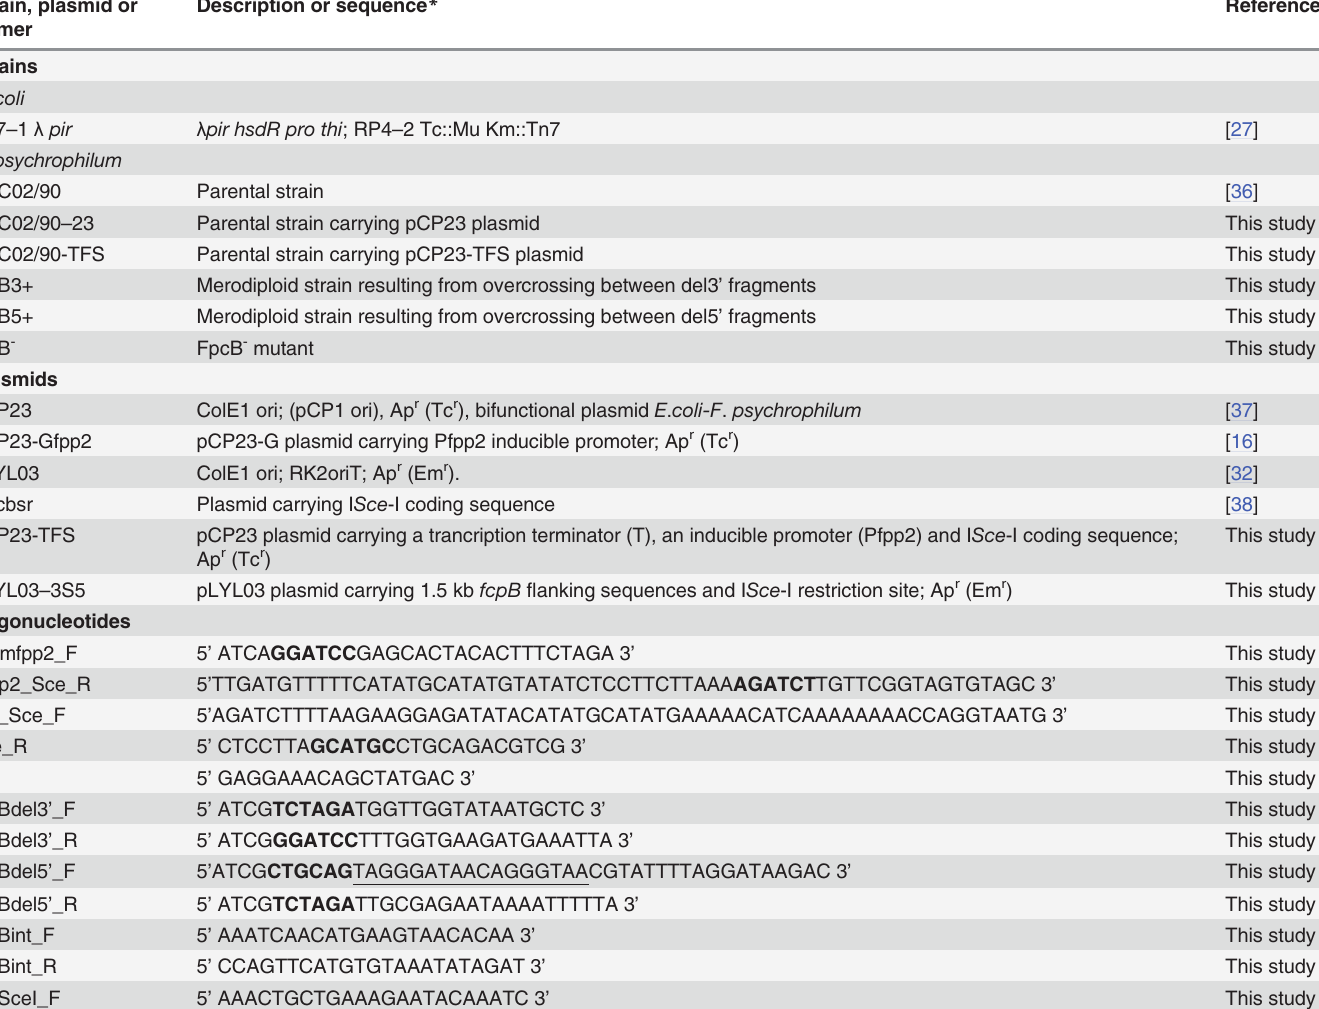
Table 1. Strains, plasmids and oligonucleotides used in this work. Strain, plasmid or Description or sequence primer